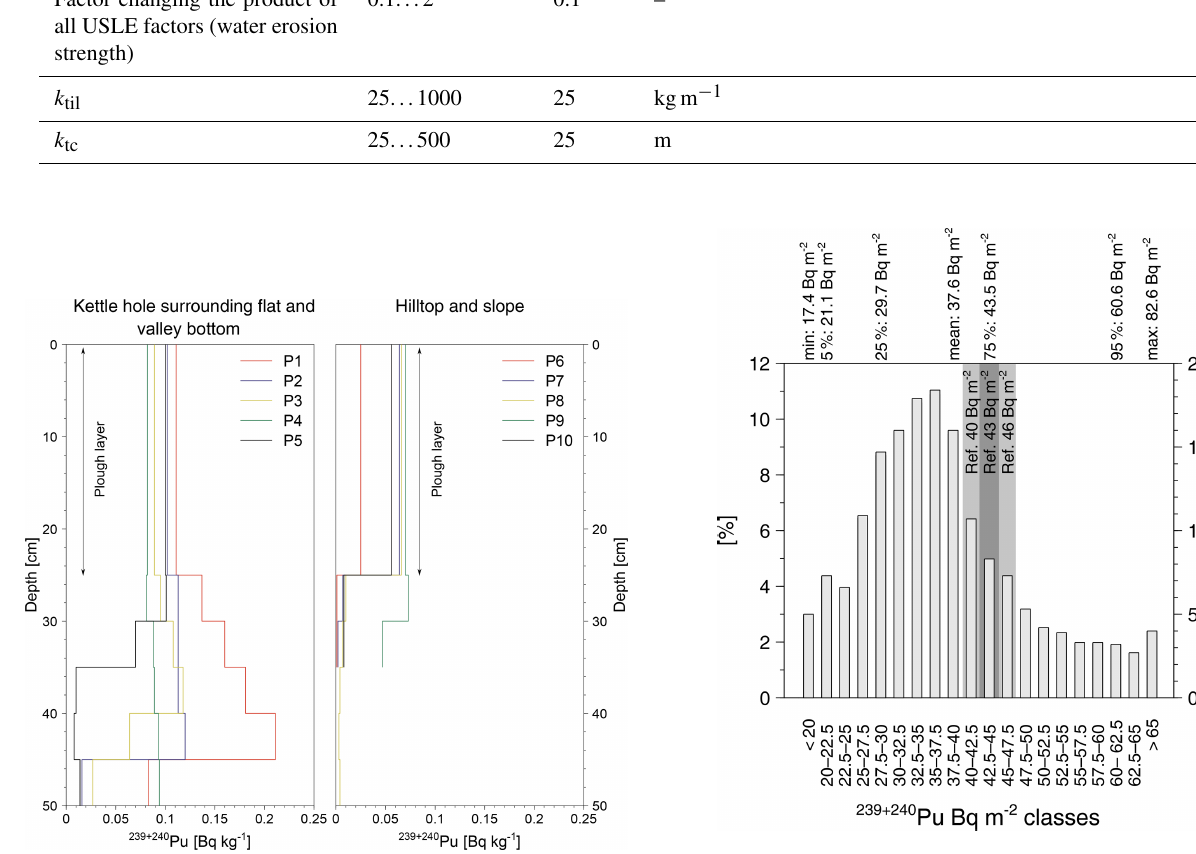
Figure 4. Distribution histogram of 5m × 5m interpolated 239 + 240 Pu measurements in 20 classes with descriptive